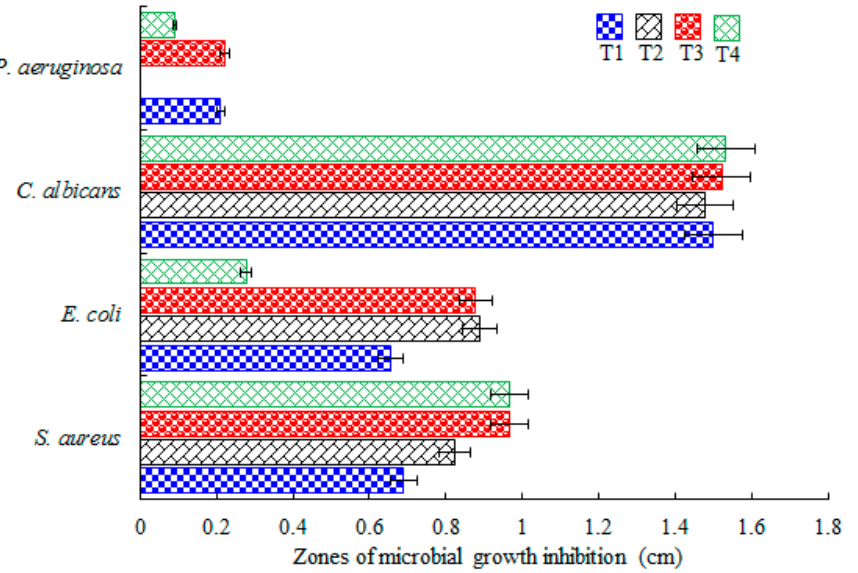
Figure 3. Antibacterial activities of four different treatments of Mexican arnica extracts against S. aureus , C. albicans , P. aeruginosa and E. coli strains. Mean area of the zones of microbial growth inhibition in cm ( n = 3).